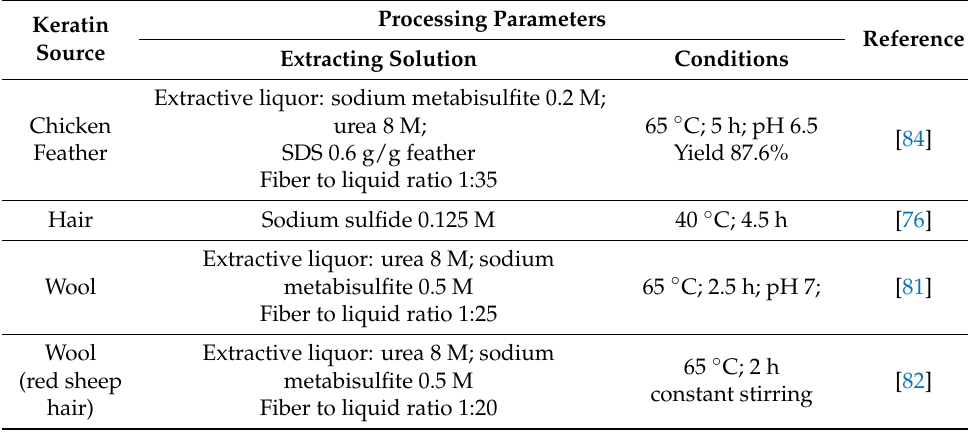
Table 4. Sulfitolysis conditions and processing parameters used for the keratin extraction.